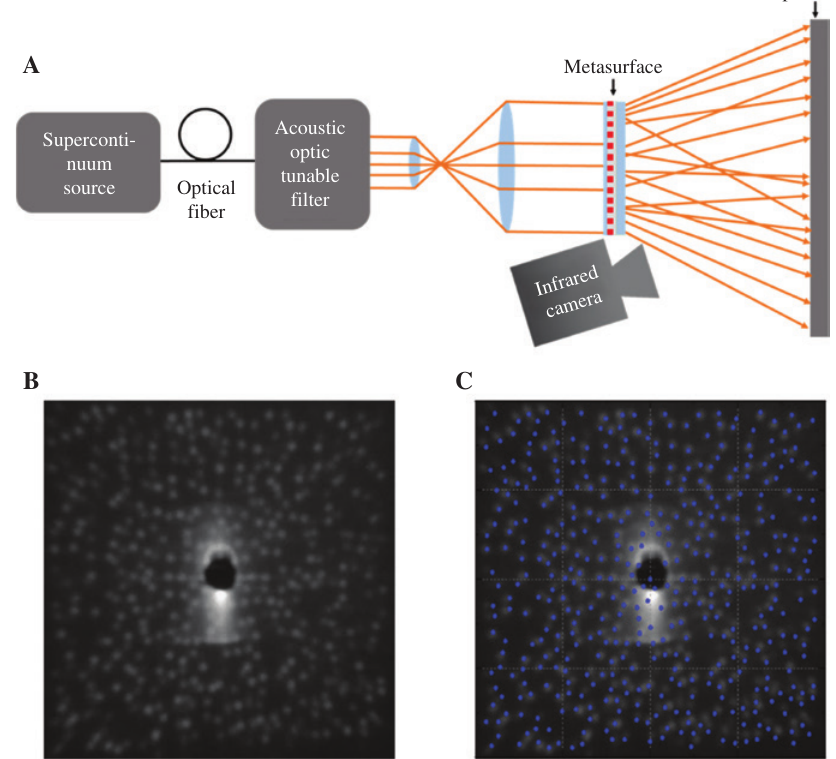
Figure 4: Characterization setup and results for the large-area pixelated metasurface beam deflector. (A) Metasurface-based random point generator characterization setup, showing expanded input laser beam injected on the device and deflected to different directions on the screen behind the metasurface device. (B) The image on the screen captured by IR camera. (C) The comparison between the designed random point array with the experimental result, showing good